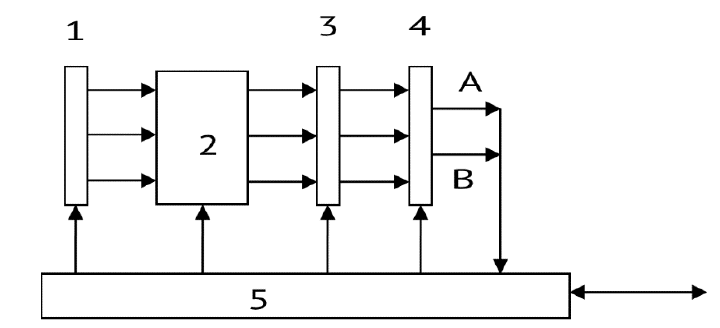
Figure 3. Optical processor for image chord